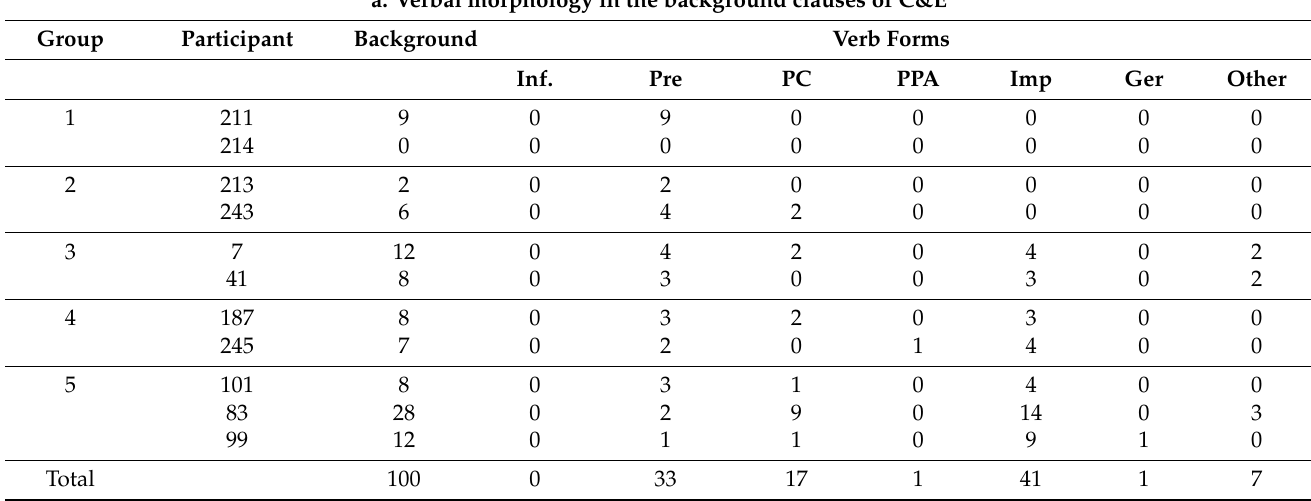
Table 5. Verbal morphology in background